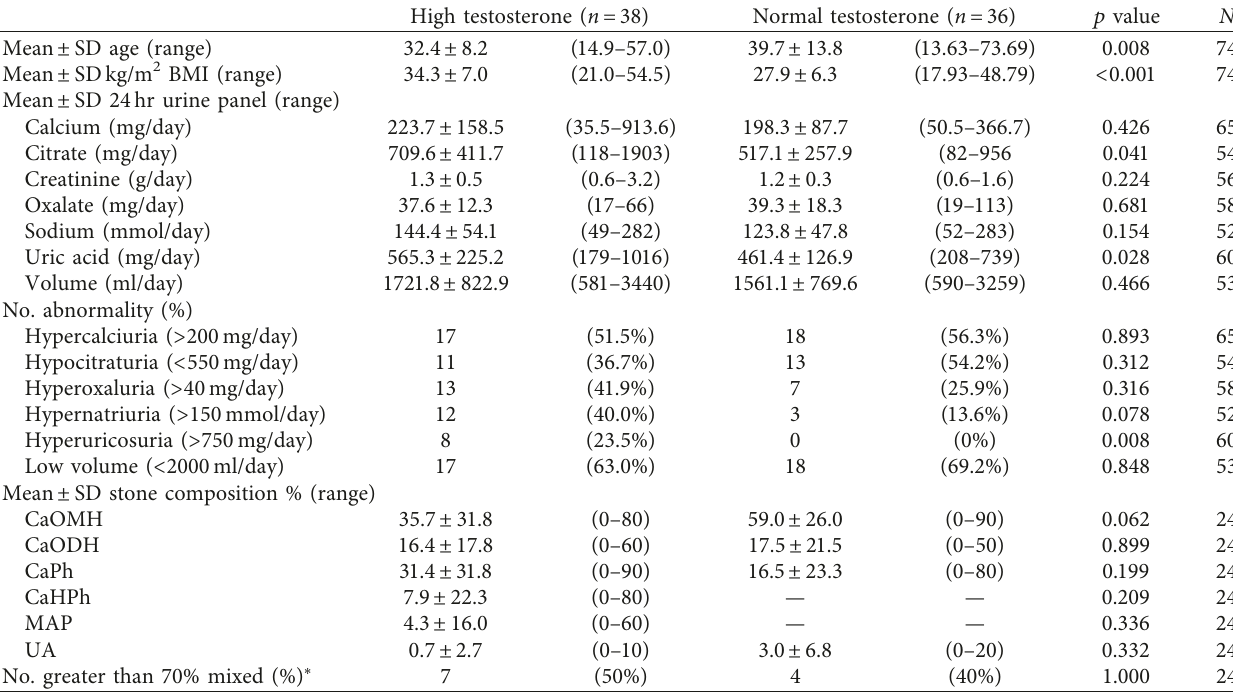
Table 2: Bivariate analysis using categorical testosterone levels within the PCOS cohort.